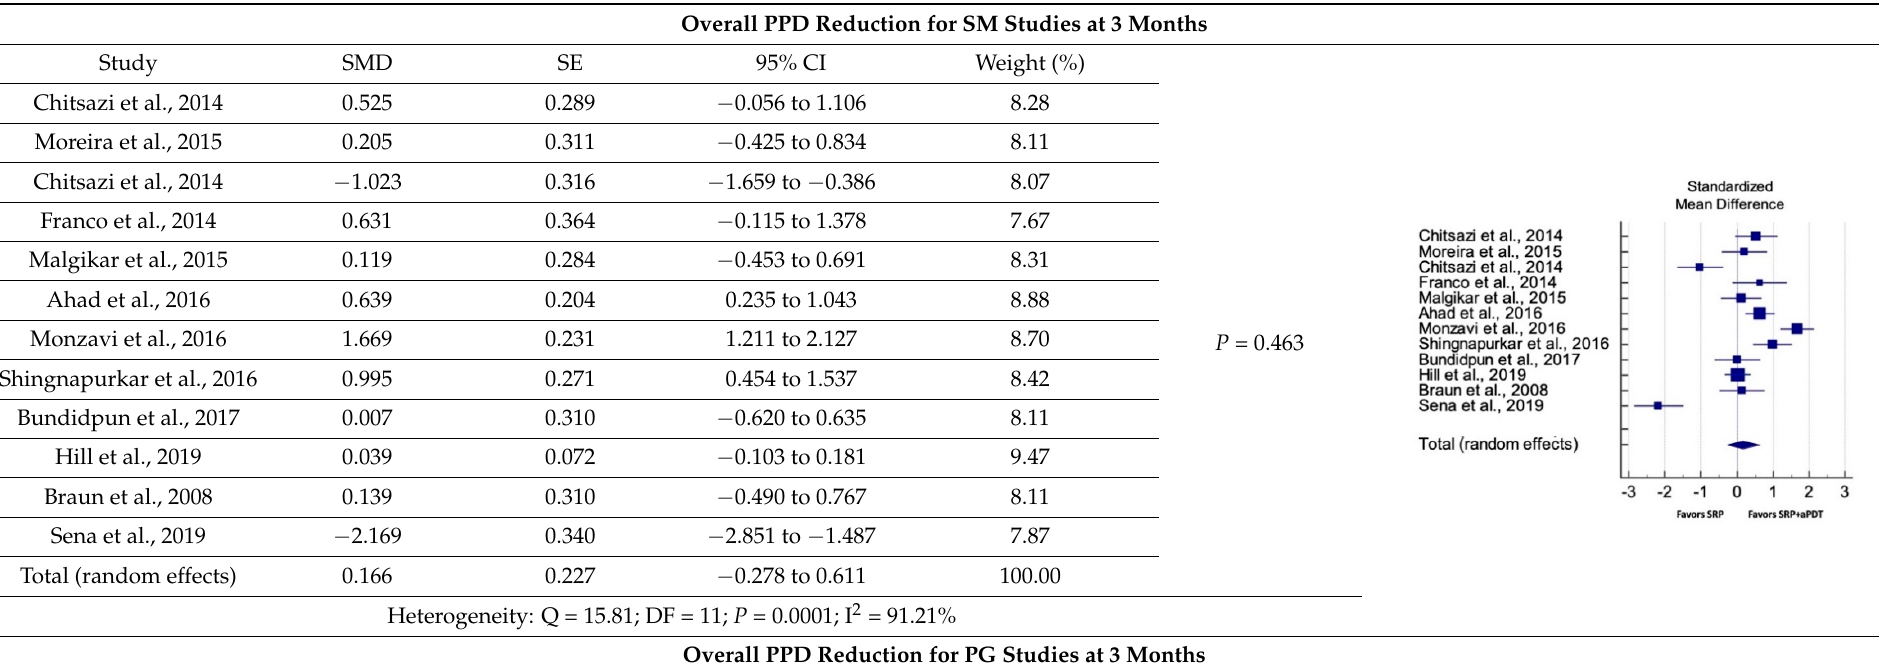
Table 3. Forest plots illustrating the overall PPD reduction and CAL gain at three months. Refer to Supplementary file 2 for a list of abbreviations.